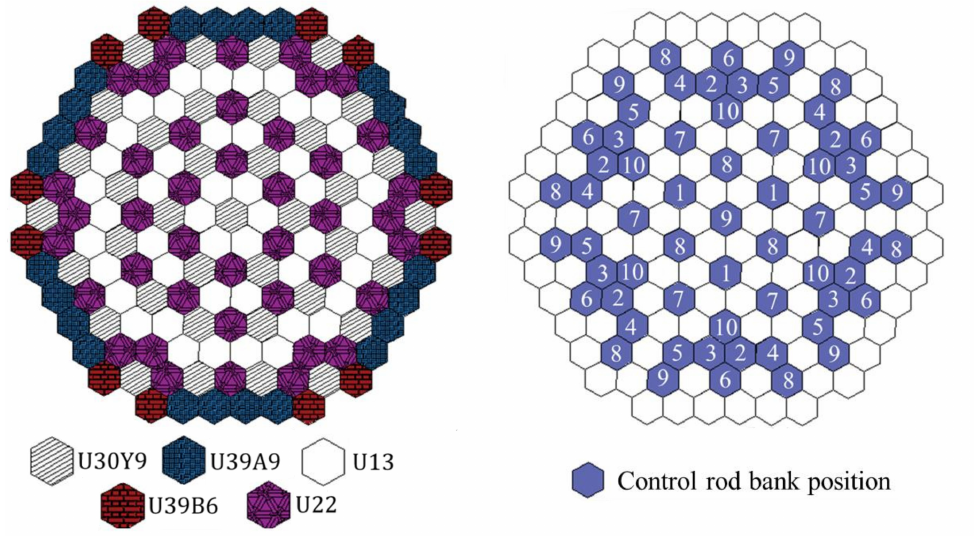
Figure 9. Radial layout of Rostov-II